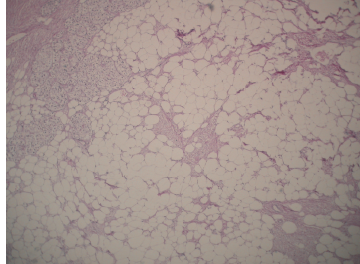
Figure 2: Thick-walled blood vessels and smooth muscle spindle cells interspersed among numerous adipocytes (magnification 200x, hematoxylin and eosin stain).